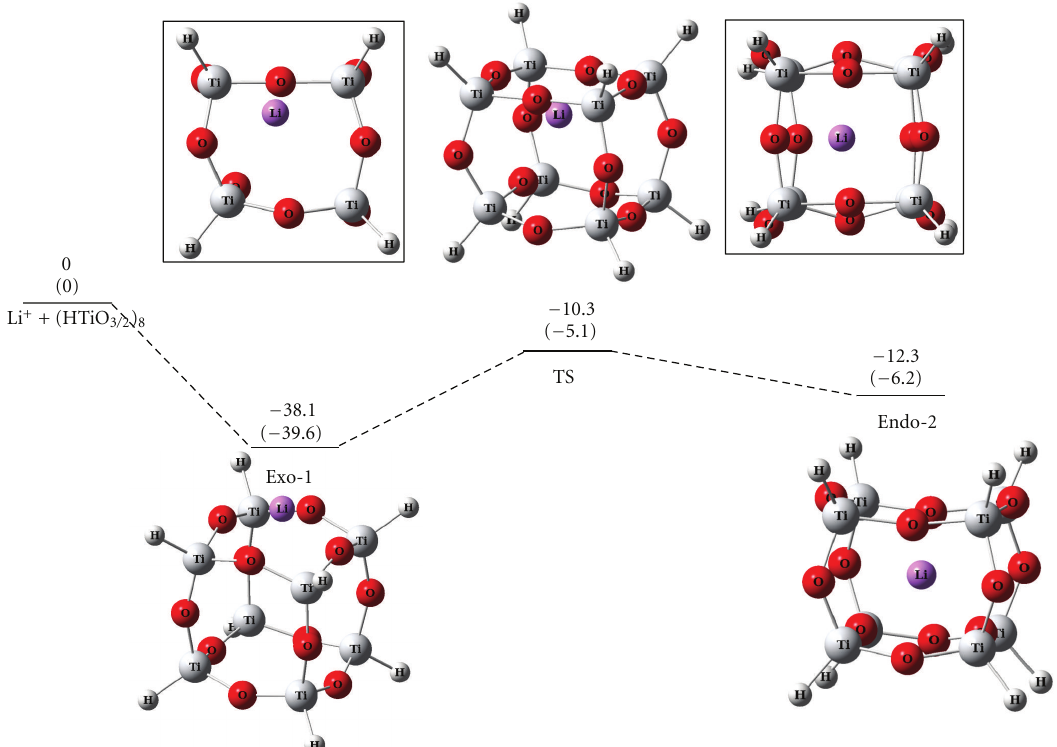
Figure 3: The potential energy surface (kcal/mol) of the insertion reaction of Li + into Ti-T 8 with the structures of the exohedral complex (Exo-1), the transition state (TS), and endohedral complex (Endo-2) at the B3LYP/6-311+G(d)+ZPC and HF/6-311+G(d)+ZPC (in parentheses) levels. For the transition state, the side view is in the left quadrangle while the top view is in the right